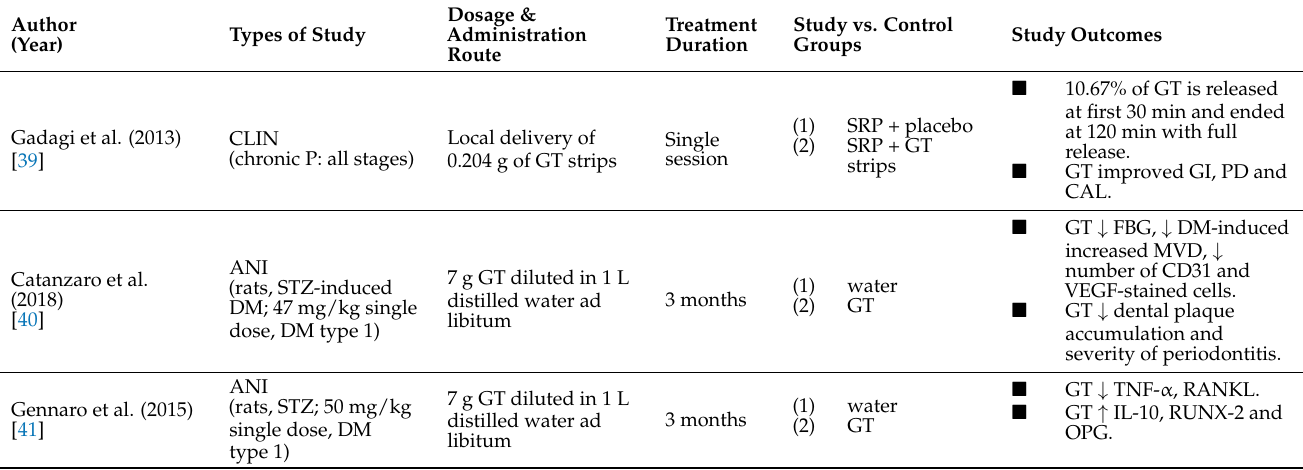
Table 7. Studies on the use of green tea (GT) in diabetes-associated periodontitis